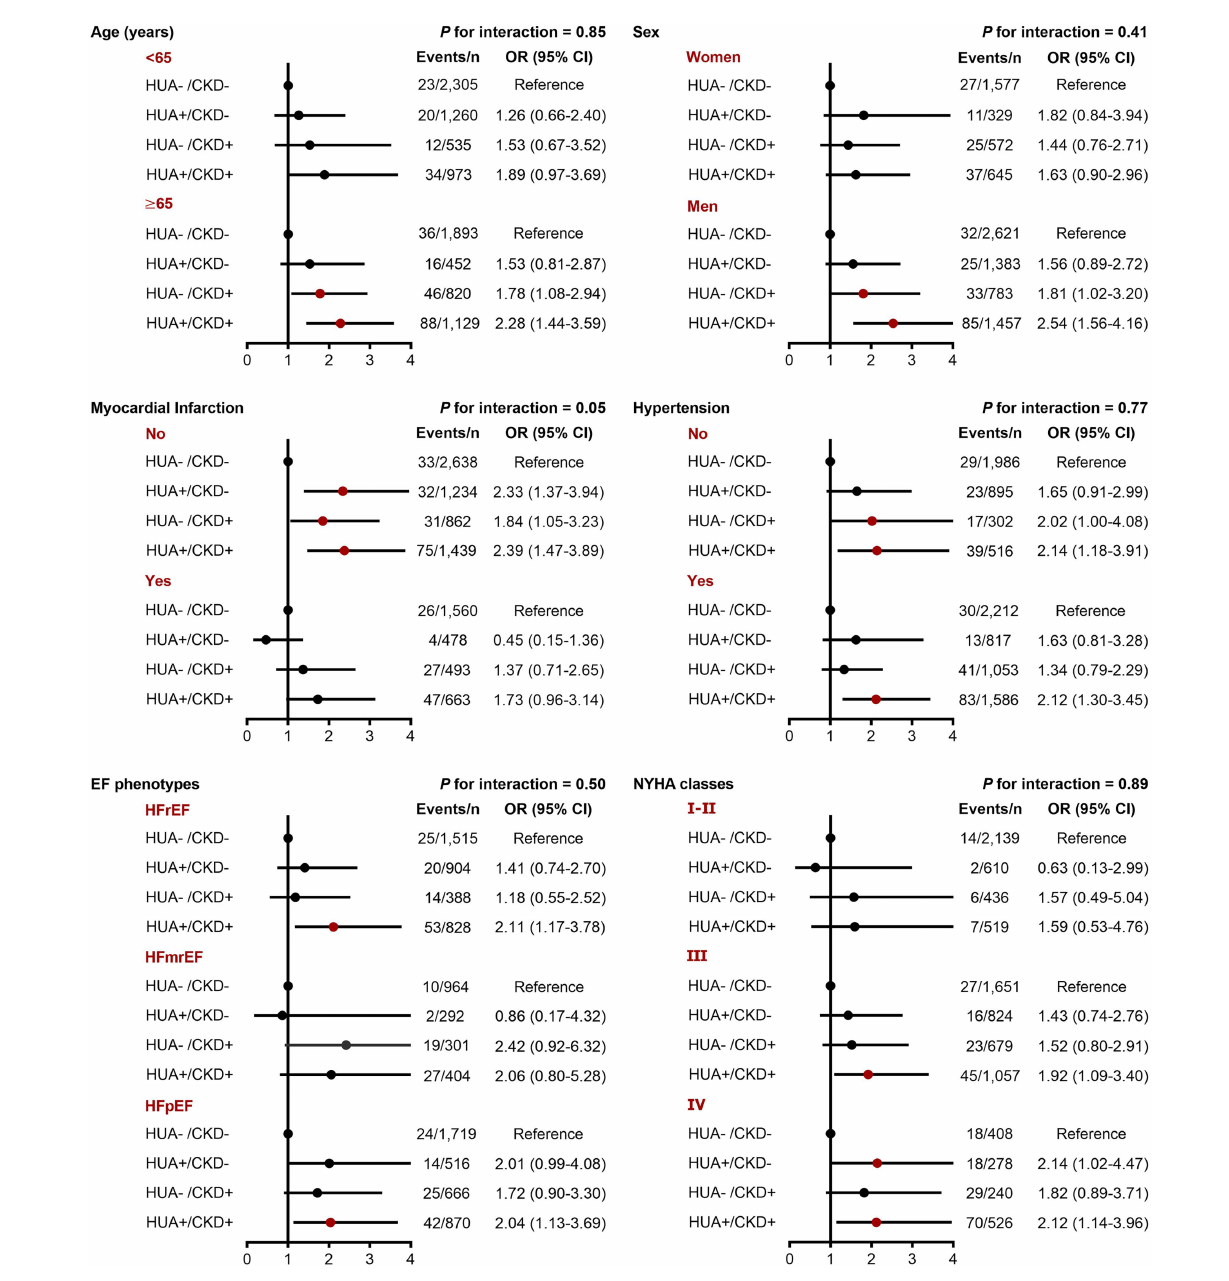
FIGURE 2 Subgroup analyses for the adjusted OR (95% CI) of hyperuricemia/CKD groups for in-hospital mortality by age, sex, myocardial infarction, hypertension, EF phenotype, and NYHA classi fi cation. CI, con fi dence interval; CKD, chronic kidney disease; EF, ejection fraction; HFmrEF, heart failure with mildly reduced ejection fraction; HFpEF, heart failure with preserved ejection fraction; HFrEF, heart failure with reduced ejection fraction; HUA, hyperuricemia; NYHA, New York Heart Association; OR, odds